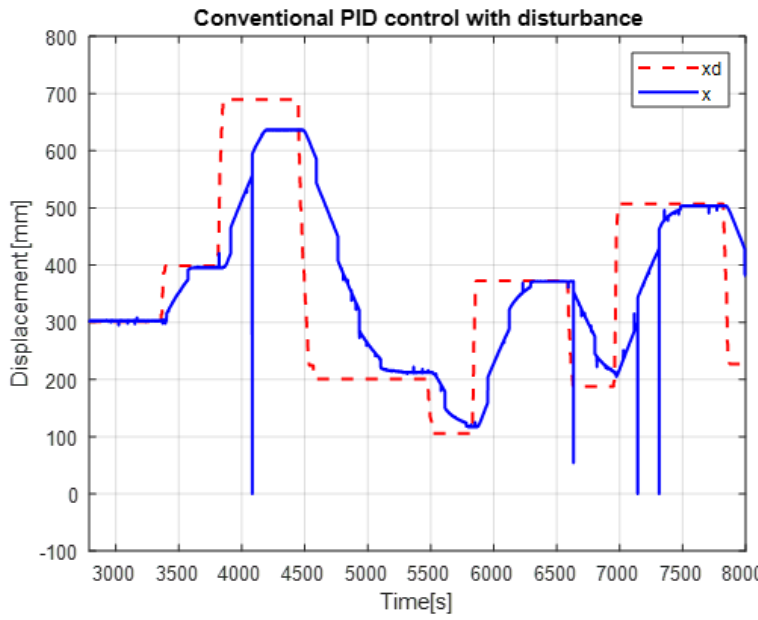
Figure 15. Real vs. desired trajectory (position change) of the auto tuning